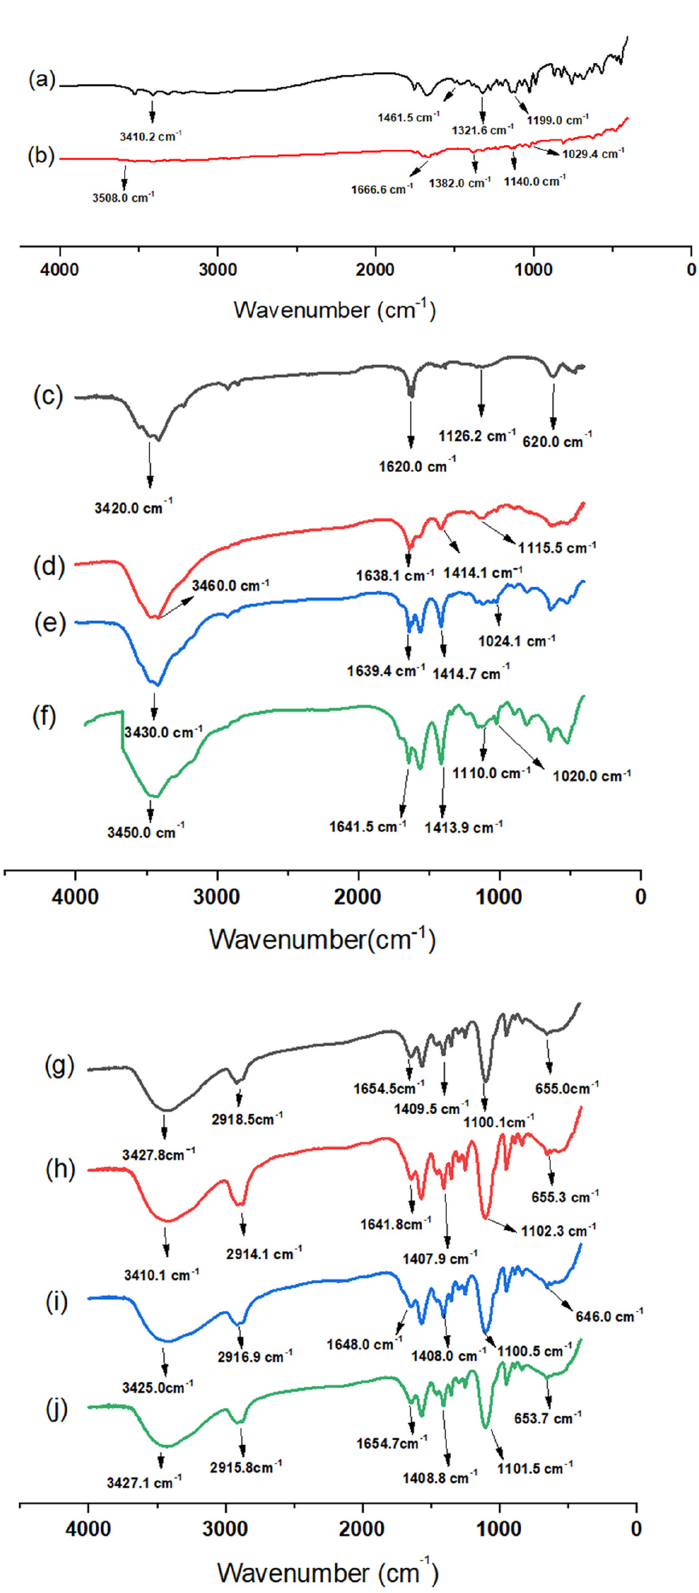
Figure 2. FTIR spectra of ( a ) pure ascorbic acid, ( b ) pure oxaliplatin, ( c ) unmodified CS NPs, ( d ) AA/CS NPs, ( e ) OX/CS NPs, ( f ) AA-OX/CS NPs, ( g ) PEG-CS NPs, ( h ) AA/PEG-CS NPs, ( i ) OX/PEG-CS NPs, and ( j ) AA-OX/PEG-CS NPs.